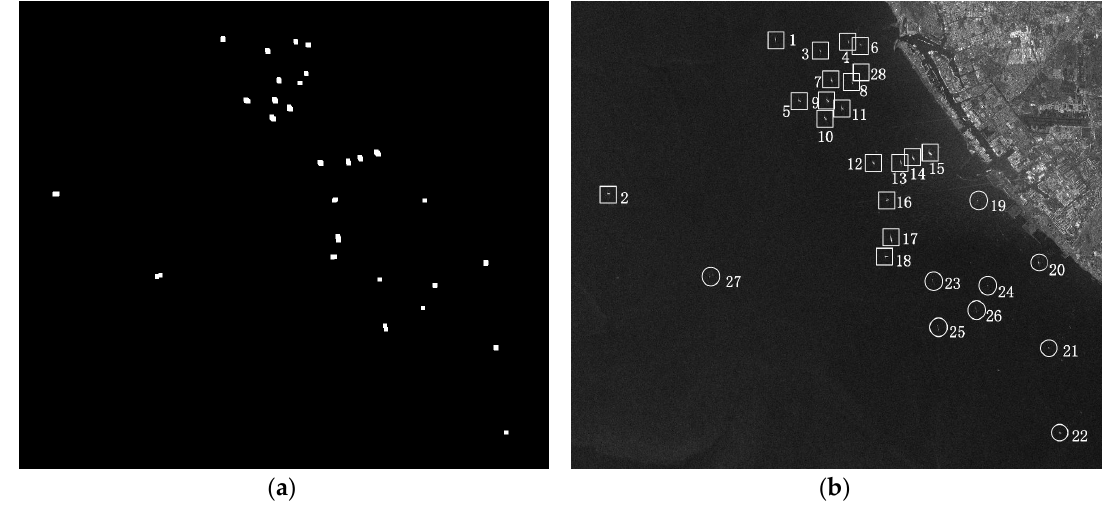
Figure 12. Prescreening results of RADARSAT-1 ROI, ( a ) The result after clustering; ( b ) The result marked in the ROI.